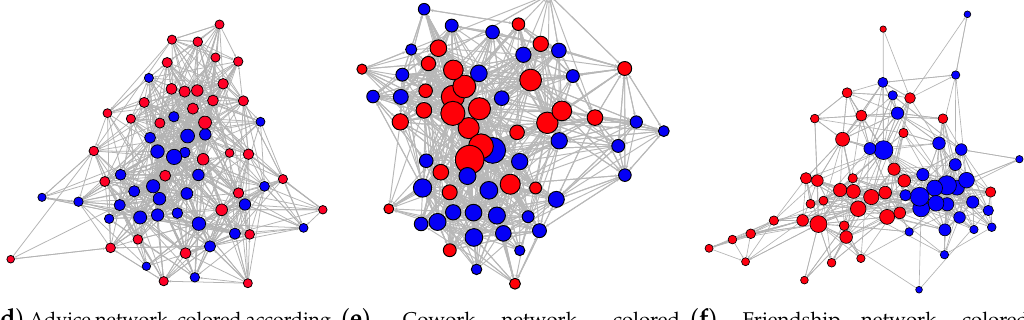
Figure 5. Plots of the three network layers, colored by the ground truth labels and the predicted labels by PAF,